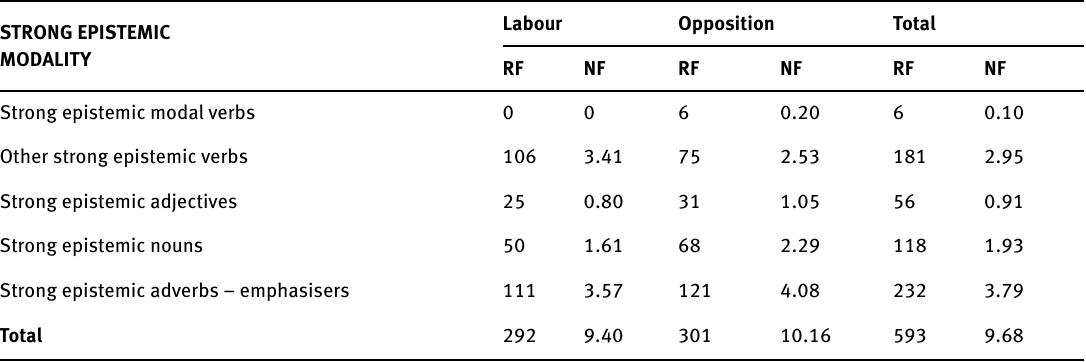
Table 7: Summary of strong epistemic